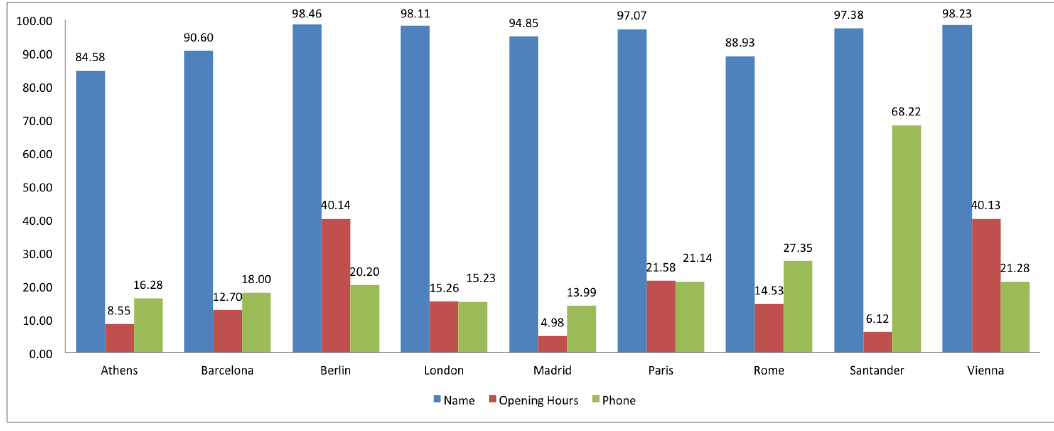
Figure 19. Completeness study in Europe. Percentage of name, opening hours and phone in